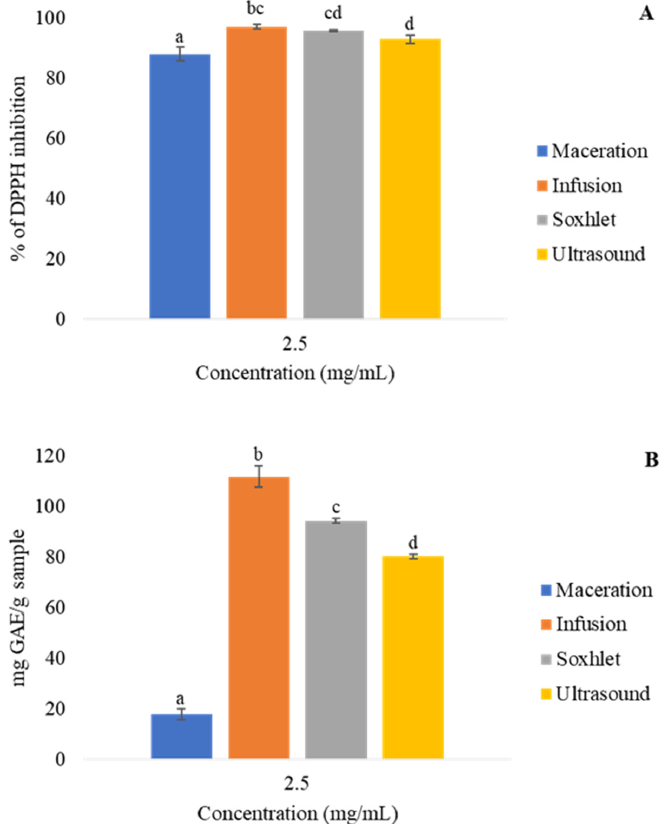
Figure 1. Antioxidant activities in DPPH ( A ) and FRAP ( B ) assays of rosemary extracts obtained from maceration, infusion, Soxhlet, and ultrasound. Results are presented as average ± standard deviation, n = 3. The letters represent significant differences between samples.